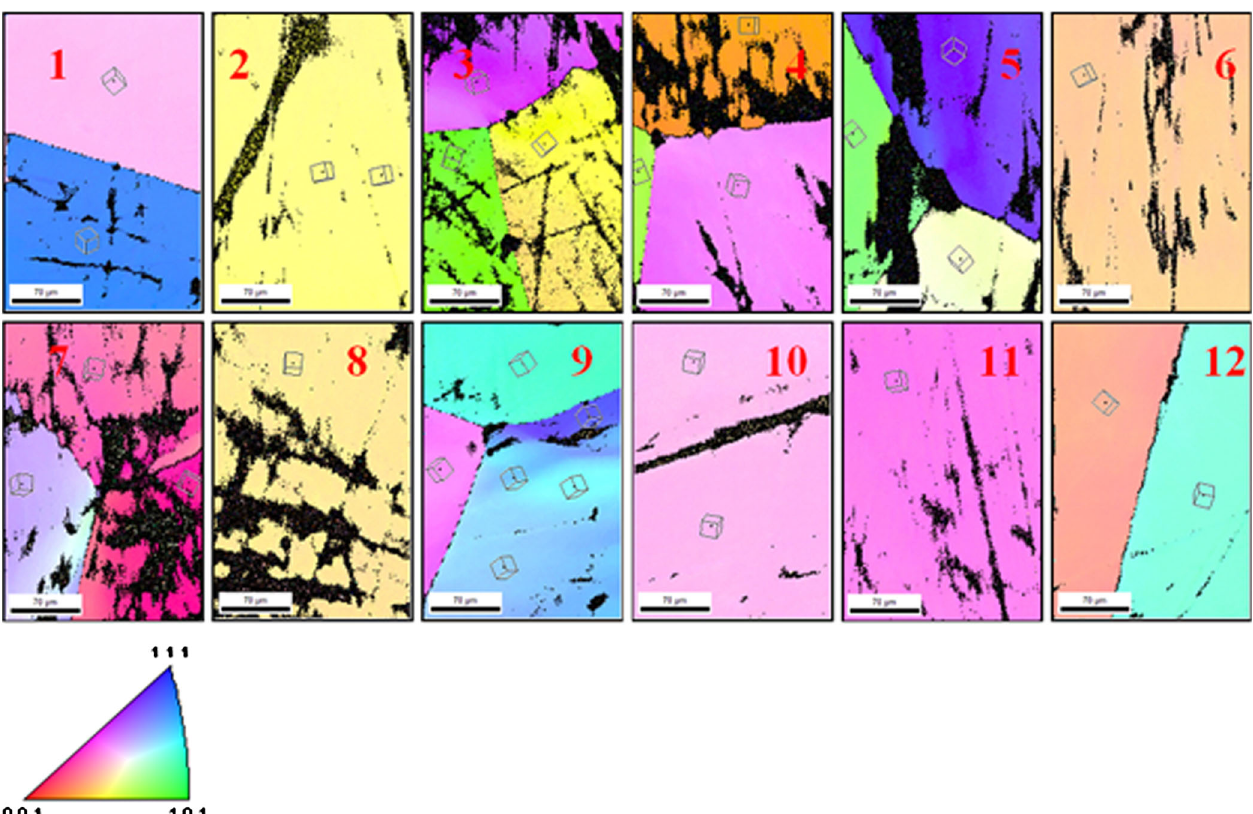
FIG. 11. Crystallographic orientation of the 12 samples measured by EBSD. Nb [001] inverse pole figure (IPF) color legend is shown on left bottom